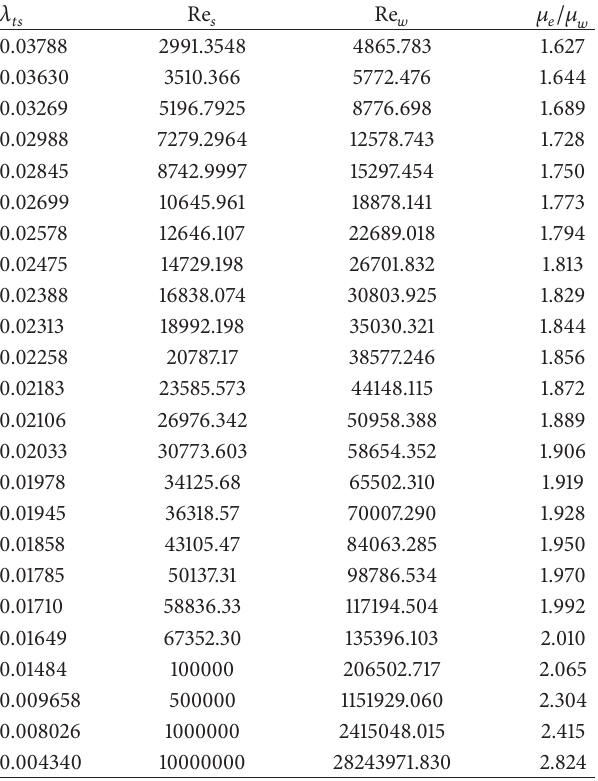
Table 2: Ratio of the equivalent viscosity to the water viscosity. 𝜆 𝑡𝑠